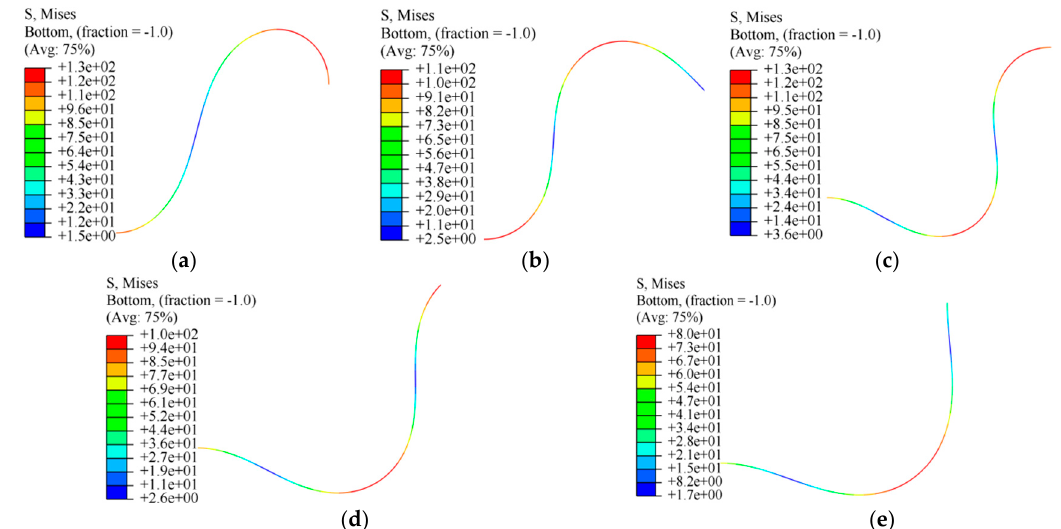
Figure 7. Deformation and stress distribution of the two point-contact guidewire computed by ABAQUS. ( a ) θ B = −π /2; ( b ) θ B = −π /4; ( c ) θ B = 0 ; ( d ) θ B = π /4 ; ( e ) θ B = π /2.